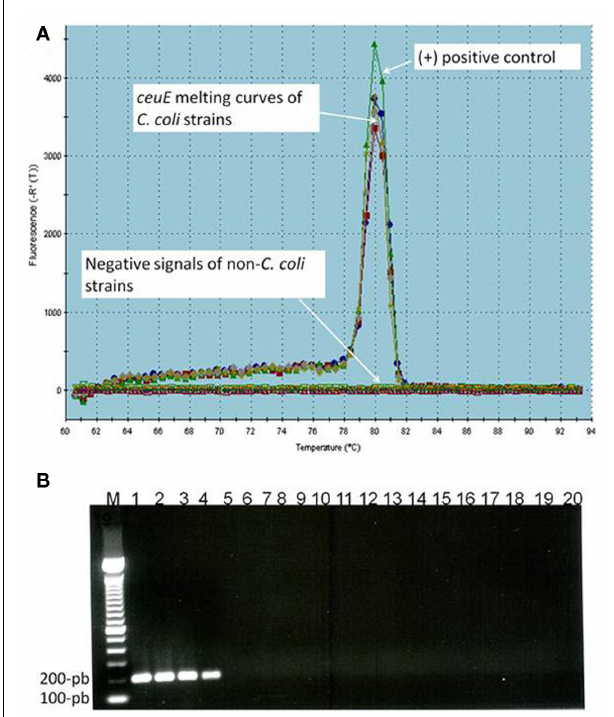
FIGURE 1 | (A) Melting temperature curve of ceuE qPCR products: ( + ) control: positive control; arrows represent ceuE melting curves of C. coli strains (4 different strains) and negative signals of non- C. coli strains (14 different strains), un-spiked samples, and water. (B) Agarose gel electrophoresis of qPCR products: Lane 1–4 (four different C. coli strains) with 196-bp band, lane M, 100-bp DNA marker; lane 5–18, 14 non- C. coli strains; lane 19, water; lane 20, un-spiked manure sample.